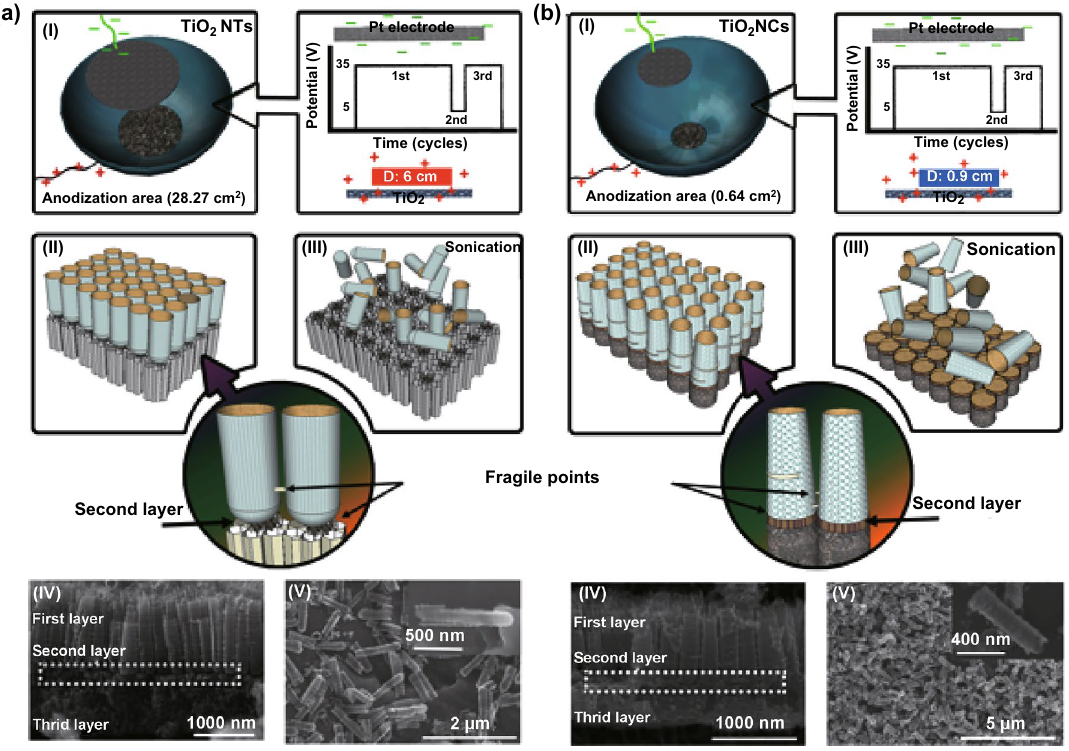
Fig. 2 Schemes and representative SEM images of separated anodic TiO 2 a nanotubes and b nanocylinders fabricated by using electrochemi‑ cal anodization. The fabrication processes of the nanotubes and nanocylinders depend on the size of anodization cell (the area exposed to the electrolyte) and quick voltage changes (first cycle: 35 V and 240 min, second cycle: 5 V and 10 min, and third cycle: 35 V and 60 min). Adapted from Ref. [10] with permission from the American Chemical